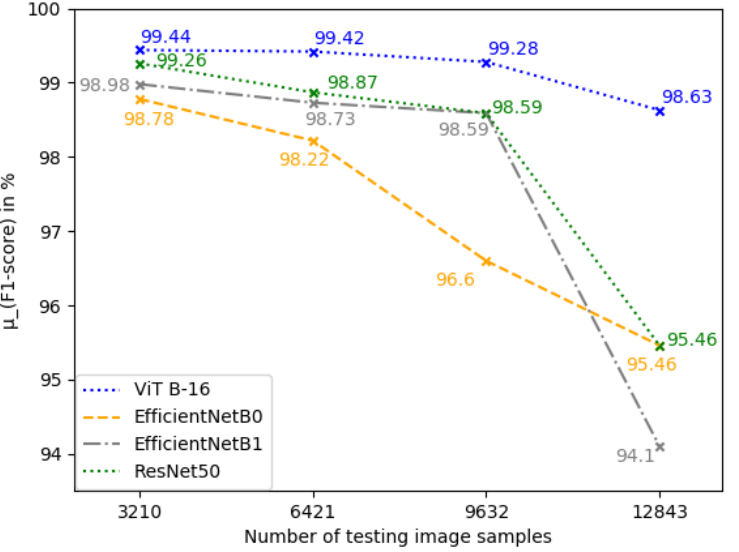
Figure 13. Comparison between ViT B-16, EfficientNet B0, EfficientNet B1 and ResNet50 on their re- spective performance with different number of testing samples while keeping 5-Fold cross-validation leaving one fold out as validation